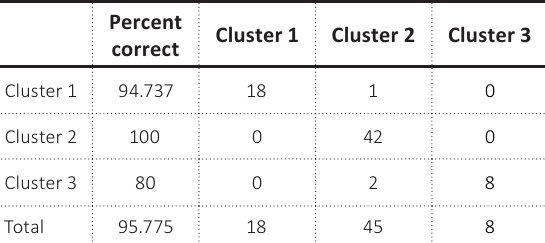
Table 2. Dispersion analysis of Ukrainian bank clusters by their reliability levels (before